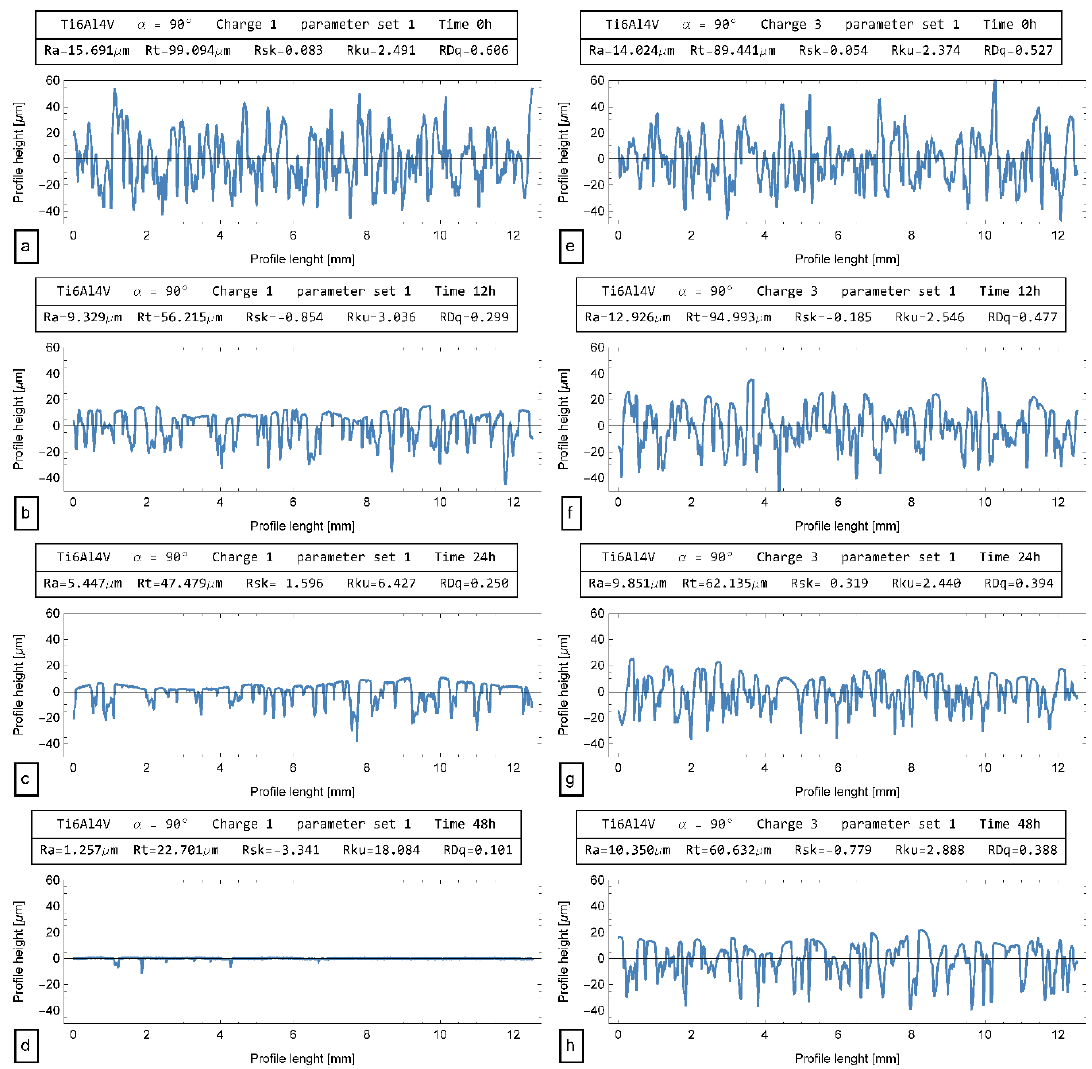
Figure 8. Ti6Al4V roughness profiles before BF conditioning (a, e) and at different working times by using parameters set 1 with charge 1 (b,c,d) and charge 3 (f, g, h).